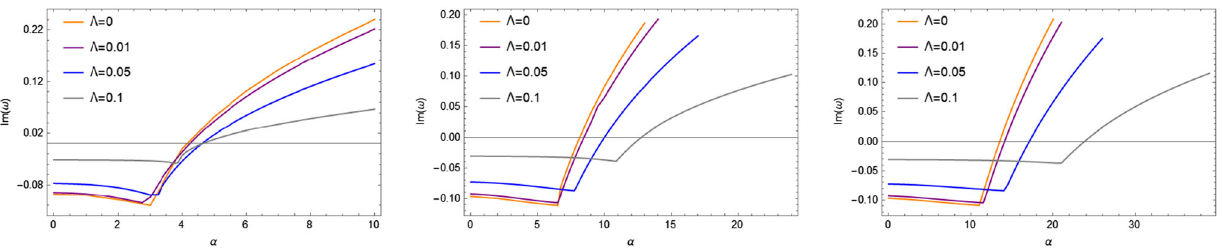
Fig. 4 The fundamental QNM frequency as a function of GB coupling for different cosmological constant. The modes from left to right are (cid:4) = 1 , 2 and 3,